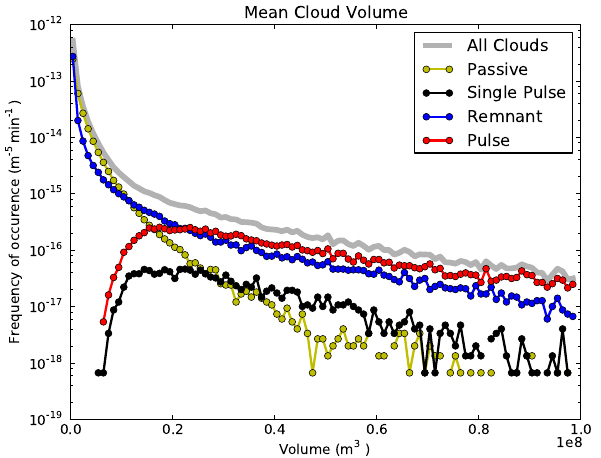
Fig. 12. Histogram of the maximum top height for all clouds, and for the different cloud